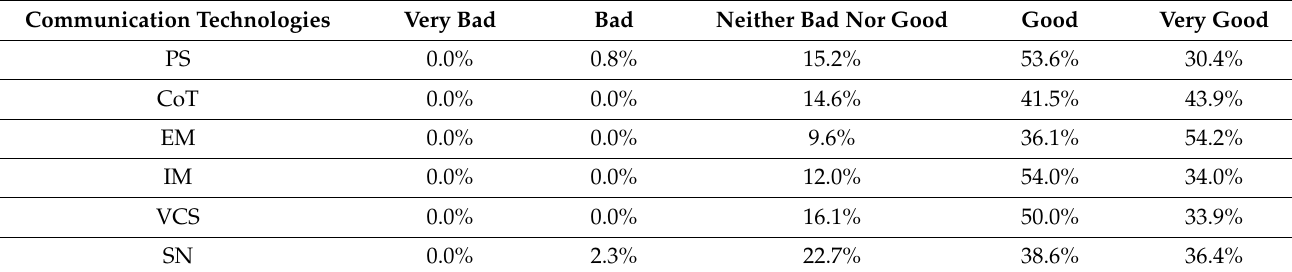
Table 14. Performance (attitude) in the use of communication technologies by teachers. Communication Technologies Very